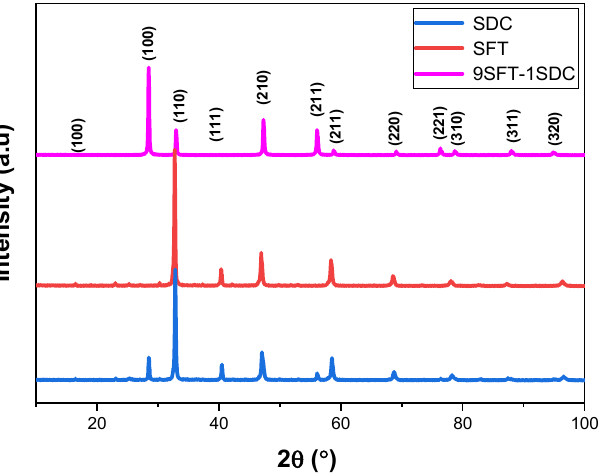
Figure 1. X-ray diffraction patterns of the fabricated 9SFT-1SDC composite cathode, SFT and SDC.